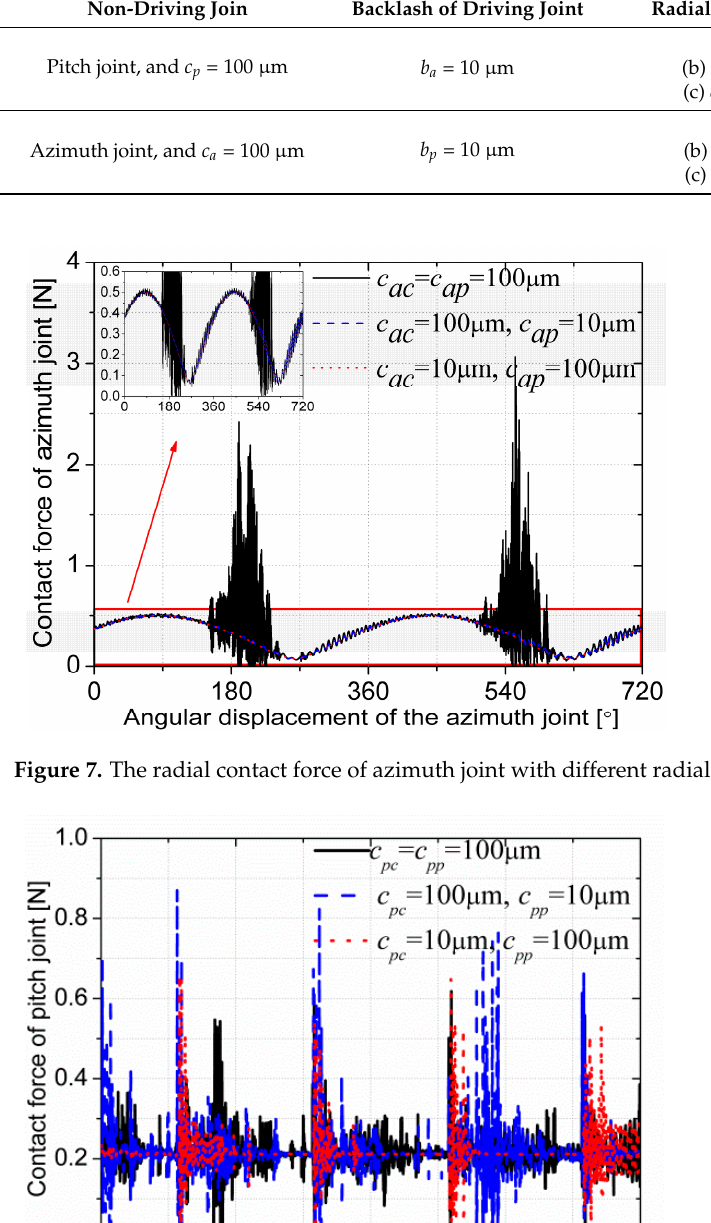
Figure 8 fluctuates greatly, it has a long stable period compared with the black solid line and the blue dashed line, which indicates that the radial clearance of the planet carrier in the pitch joint affects small changes in contact force. When the radial clearance of the planet carrier is small, the change of contact force is relatively stable. However, the differ- ence is that the number of peak points of the blue dashed line is more than the other lines. The peak value is large, which shows that when the radial clearance of the planet carrier c pc is 100 μ m, and the radial clearance of the planetary gear c pp is 100 μ m; the coupling effect between the radial clearance is obvious, which results in a large value of the radial contact force. From the above analysis, under the special coupling of radial clearance, the radial contact forces of the azimuth joint and the pitch joint fluctuate greatly, which will aggra- vate the wear and fatigue in the joint. It may cause the radial vibration of the antenna reflector and affect the dynamic pointing accuracy of the satellite. To reveal the effect of radial clearance coupling on the vibration characteristics of the system further, through analysis method of frequency characteristics, the variation law of vibration amplitude of the satellite antenna reflector in the single-axis driving mode is presented, as shown in Figure 9. It can be found that the peak value of the vibration appears for the antenna re- flector at a certain radial clearance size; there are four in Figure 9a and three in Figure 9b. The peak point values are listed in Tables 4 and 5, respectively.